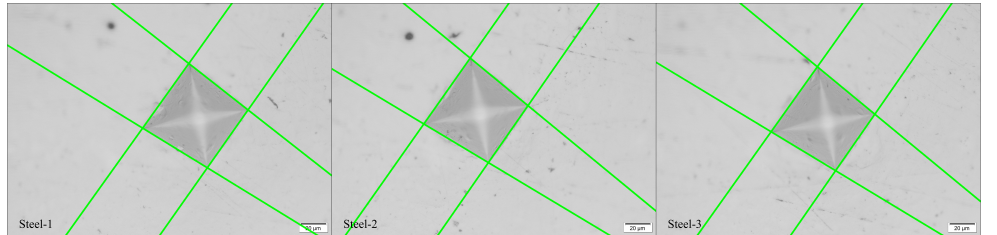
Figure A6. Corner detection on TiNbN samples at 10N applied force.